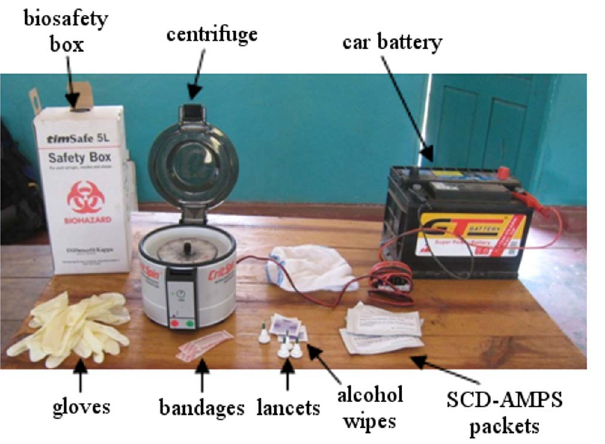
Fig. 5. Equipment for the SCD-AMPS rapid test. All the equipment necessary to run the rapid test in a rural clinic fits inside a backpack and were evaluated at rural health centers in